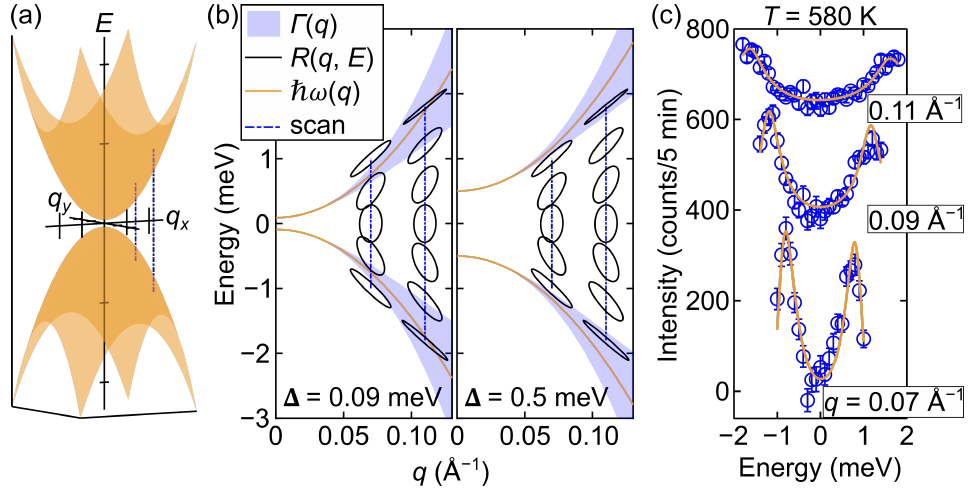
Figure 2. ( a ) A three-dimensional schematic of an isotropic parabolic spin wave dispersion near Q = 0 and energy transfer, E = 0. The dispersion is shown as the orange surface, and dashed blue lines show the direction of constant- Q scans cutting through the dispersion surface along E . ( b ) A two-dimensional schematic demonstrating how the experiment captures the intensity from the spin wave excitations. The orange solid line represents the dispersion, ¯ h ω ( q ) = ∆ + D ( T ) q 2 , and the surrounding blue surface represents the full-width-at-half-maximum of the spread in energy of the dispersion, Γ ( q ) , due to thermally induced magnon-magnon interactions. Dashed blue lines are examples of constant- Q scans made in the experiment. Overlayed on these lines are the instrumental resolution ellipses, R ( Q , E ) , along Q = 0.07 Å − 1 and 0.11 Å − 1 . The left panel uses the refined values for the dispersion from the actual data at T = 580 K in the E i = 35 meV experiment. The right panel uses the same parameters, but increased the gap to be 0.5 meV in order to demonstrate the sensitivity of the technique to the size of the gap. Here, the scans performed during the experiment wouldn’t be able to reach the signal of the spin waves. ( c ) The actual data at T = 580 K in the E i = 35 meV experiment. The solid orange lines are the refined fits to the data, shown as blue circles. The three constant- Q scans are vertically offset from one another for